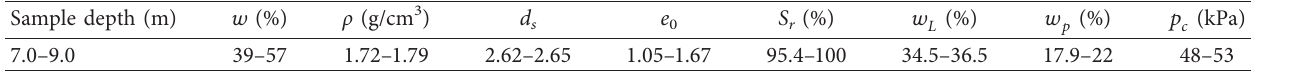
Table 1: The physical properties of soft clay used in this study.